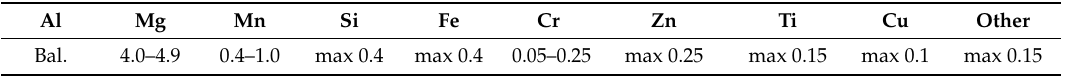
Table 1. Chemical composition of the 5083-H111 aluminum alloy (wt. %).